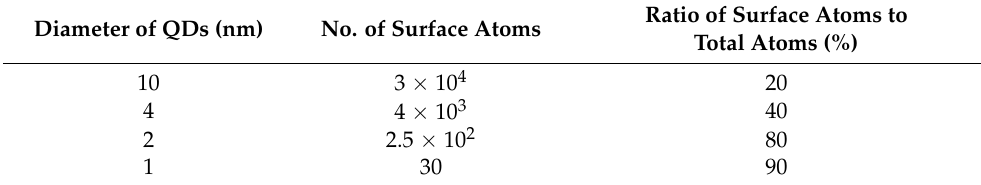
Table 3. Relationship between the size of QDs and the number of surface atoms. Diameter of QDs